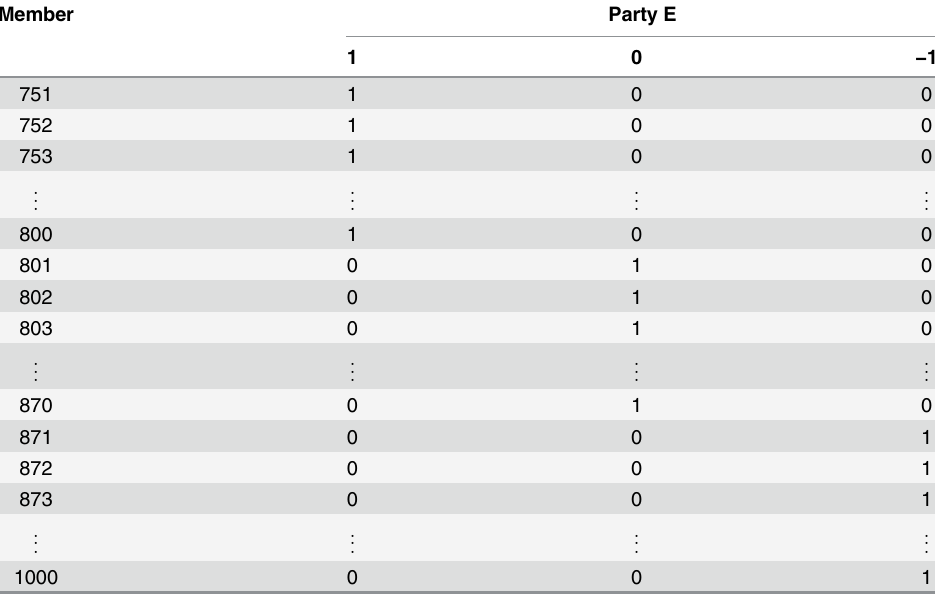
Table 7. A decomposition of Table 2 into multi-tables of Boolean-valued for Party